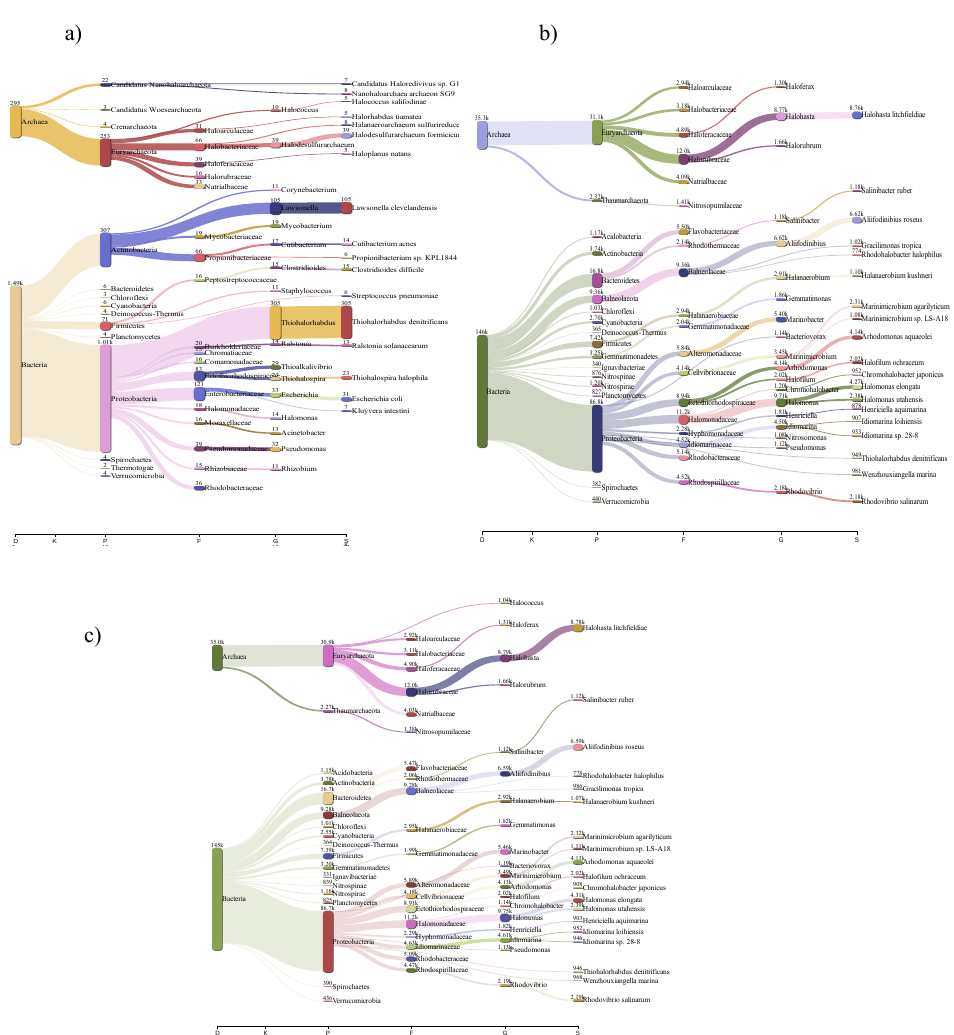
Figure 2. Taxonomic profile in hypersaline metagenomes from Cusco, Per ú . ( a ) Maras; ( b ) Acos 1; ( c ) Acos 2. On the x -axis are the taxonomic levels: D, domain; P, phylum; C, class; O, order; F, family; G, genus; S, species. Numbers correspond to the assigned contigs.